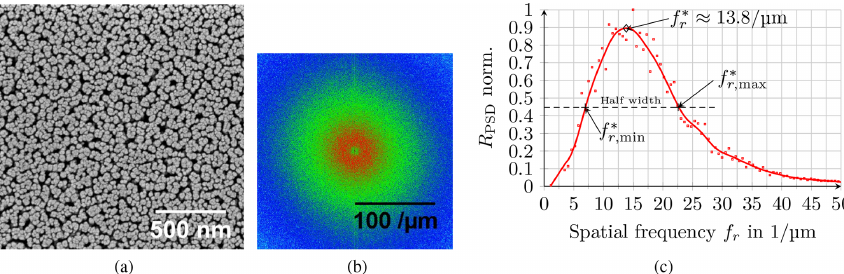
Figure 3. Procedure to evaluate the dominant spatial frequency from an SEM image. (a) The starting point is an SEM image of the top view of tantalum columns produced with GLAD; (b) power spectral density of the top view according to Eq. (4), where high gray values are colored red and the ring-shaped pattern is revealed; (c) plot of the angular-averaged power spectral density according to Eq. (5) with marking of the dominant spatial frequency f ∗ r . The range of variation f ∗ r , max − f ∗ of the dominant spatial frequency is defined by the half-width r , min (dashed line) (Buzea et al.,